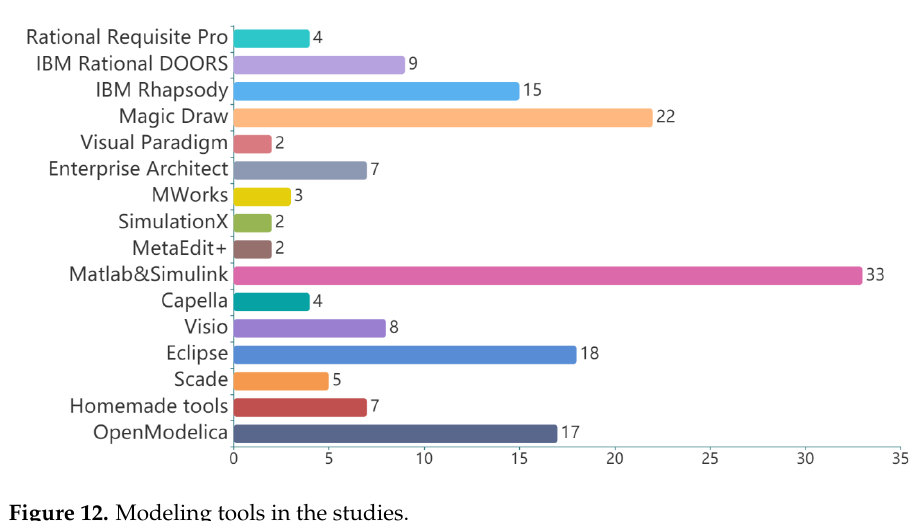
Figure 12. Modeling tools in the studies.